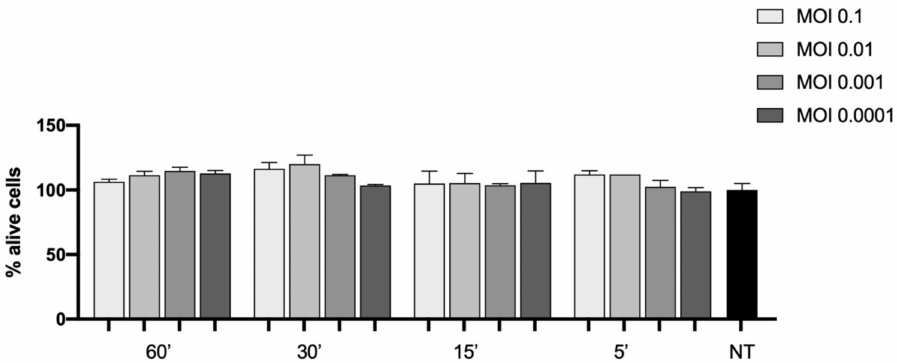
Figure 3. Viability of the cells infected with different virus concentrations (MOI 0.1, 0.01, 0.001, and 0.0001) and different timings of viral absorption (60, 30, 15, and 5 min) at 7 days post infection. The results are presented as percentage with respect to the cells not treated (indicated as NT in black).